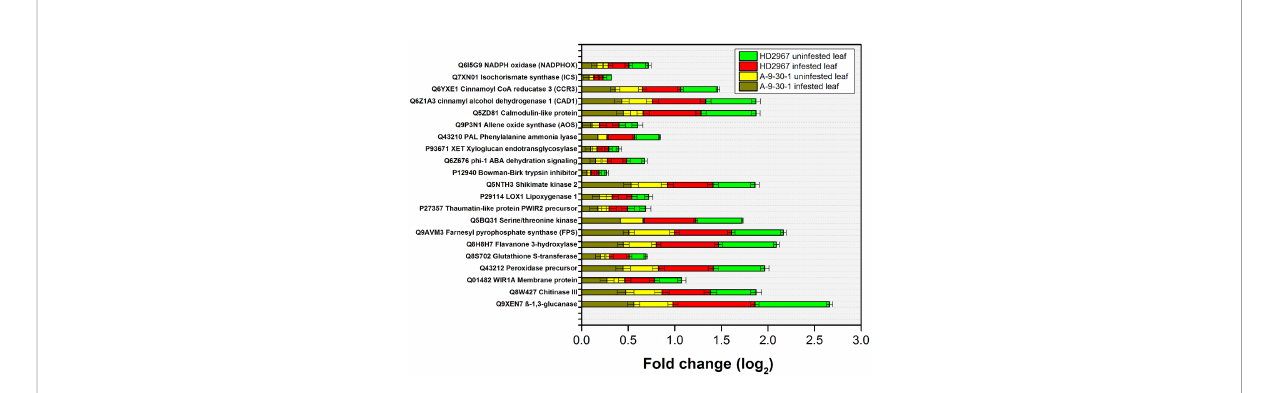
FIGURE 4 Spatiotemporal real-time PCR expression analysis of defense-related genes in wheat before and after attack of